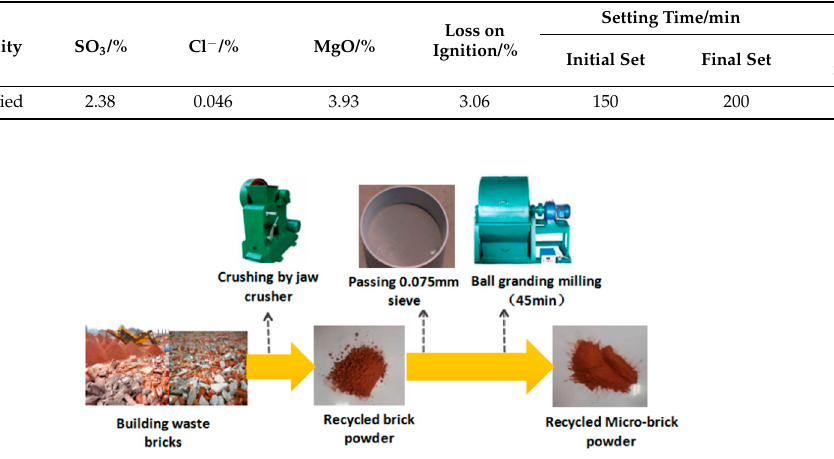
Table 1. The main technical indexes of cement.